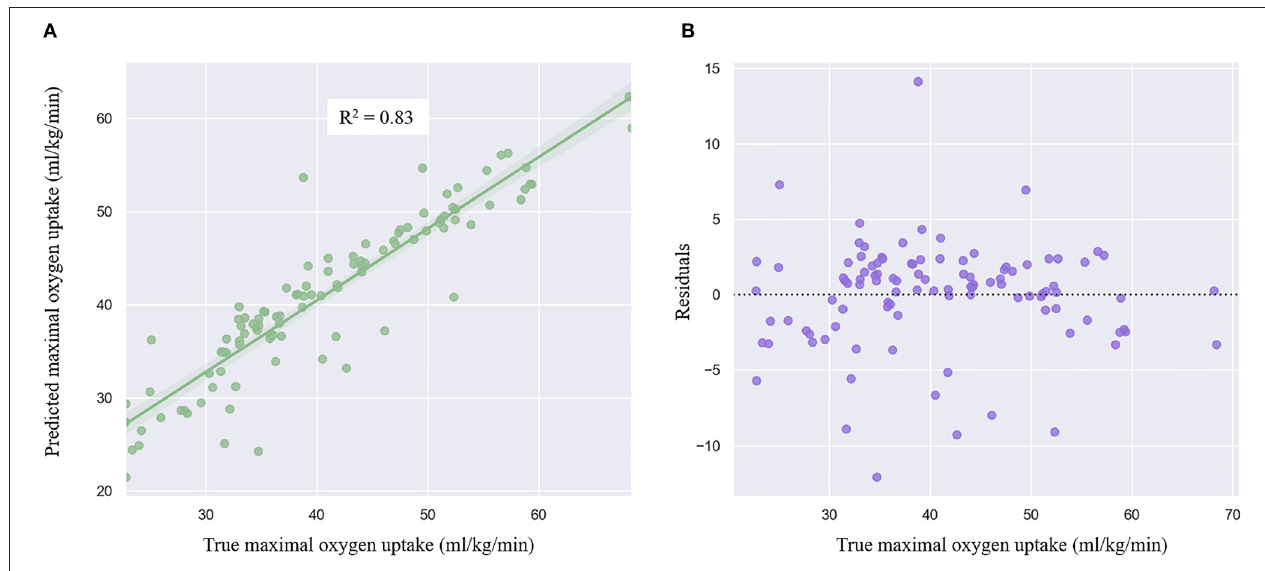
FIGURE 3 | Regression plot (A) and residuals plot (B) of the linear regression model.